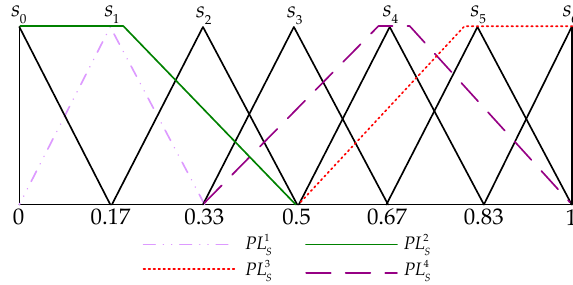
Figure 3. Fuzzy envelopes obtained from Example 2.